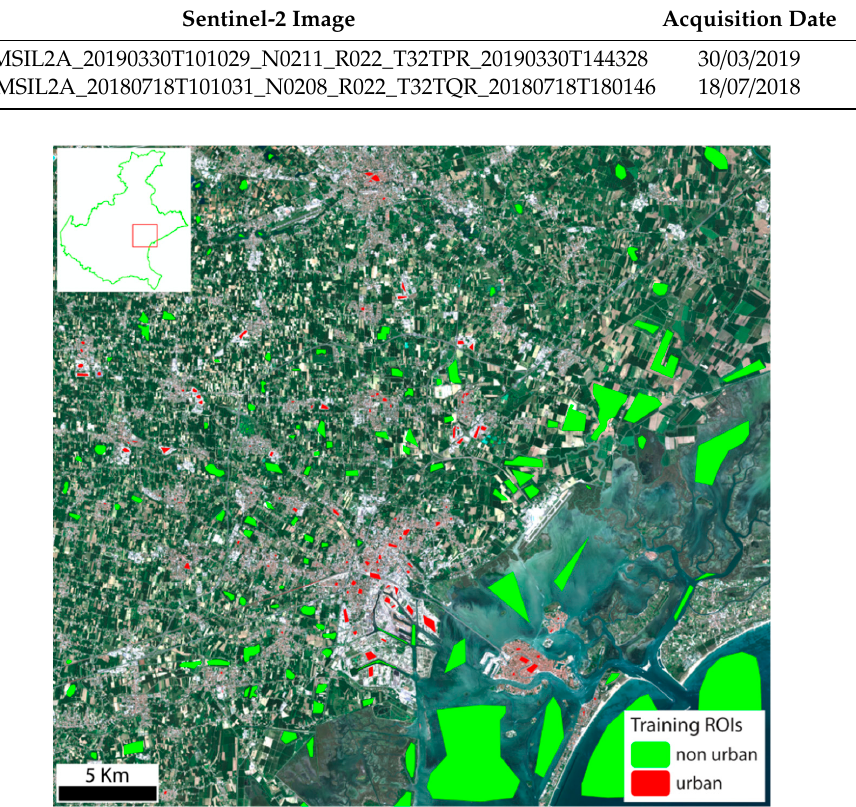
Table 2. All the Sentinel-2 images used in this work. Downloaded from the Sentinel Open Access Hub [48].